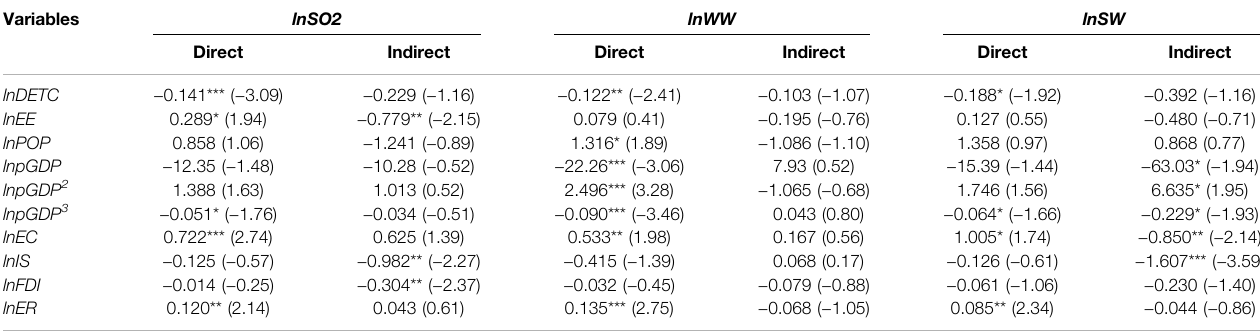
TABLE 4 | The direct and indirect effects of the spatial econometric model. Variables